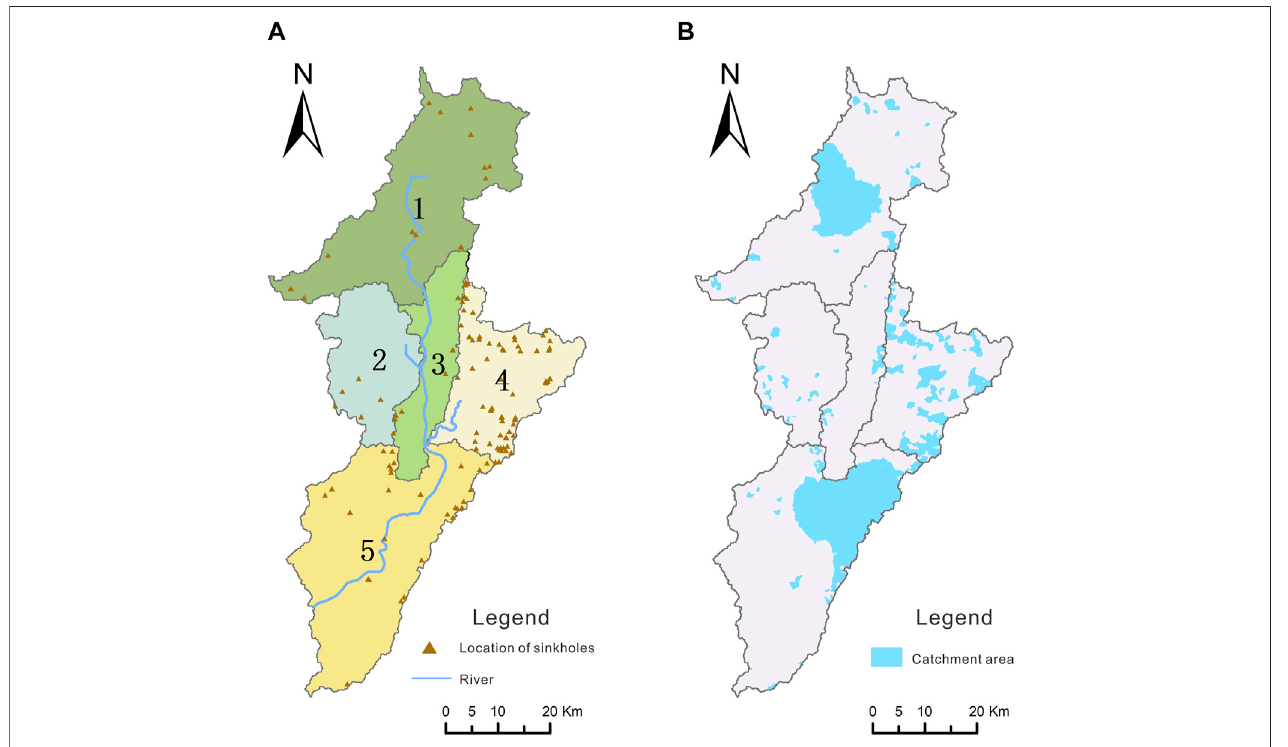
FIGURE 5 | Division of watershed and location of sinkholes (A) . Catchment area of the sinkholes in each subbasin (B) .